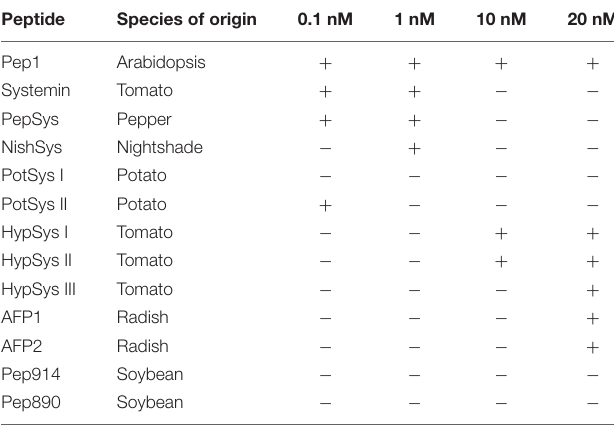
TABLE 1 | Peptides Induced-Resistance assays summary table. Peptide Species of